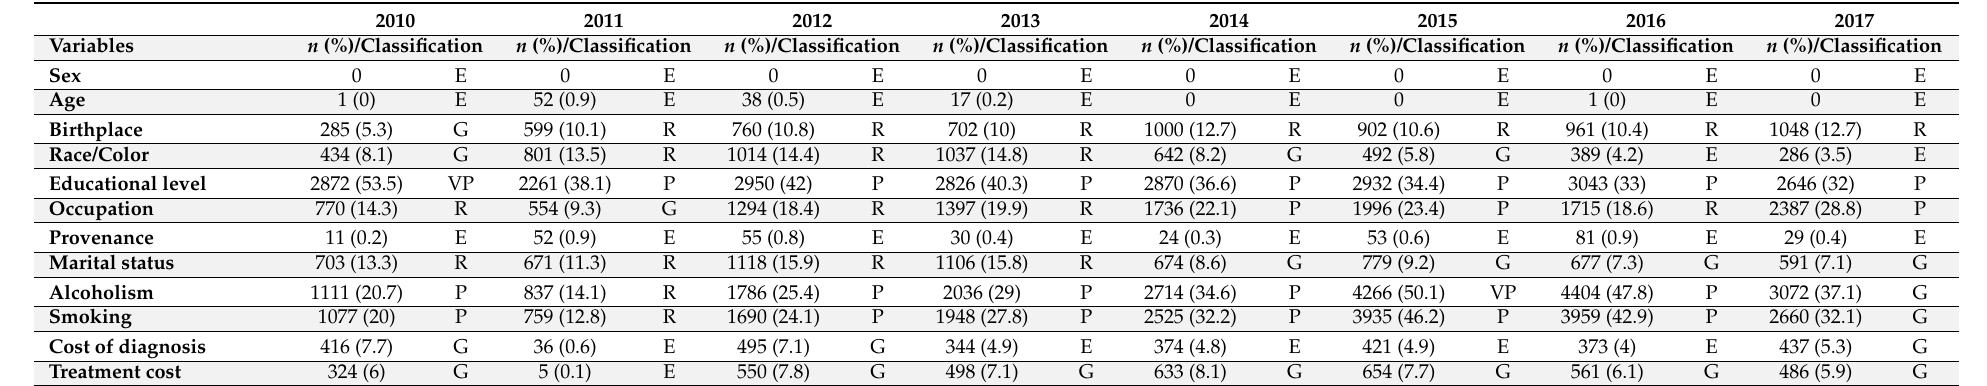
Table 2. Absolute frequency and percentage of missing HCR data and classification of the completeness of sociodemographic variables between 2010 and 2017. Vit ó ria, ES, Brazil.